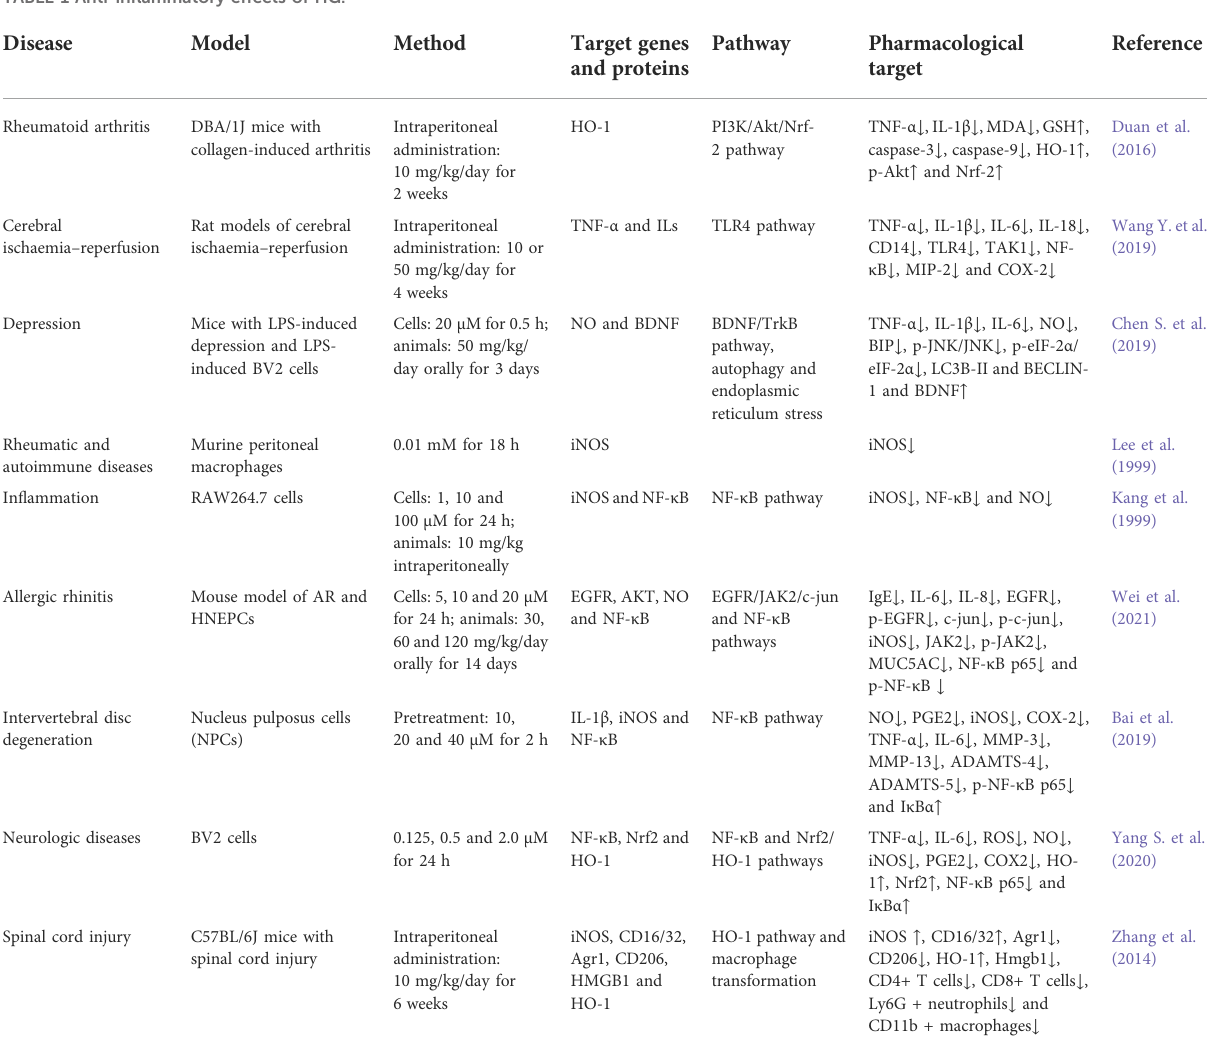
TABLE 1 Anti-in fl ammatory effects of